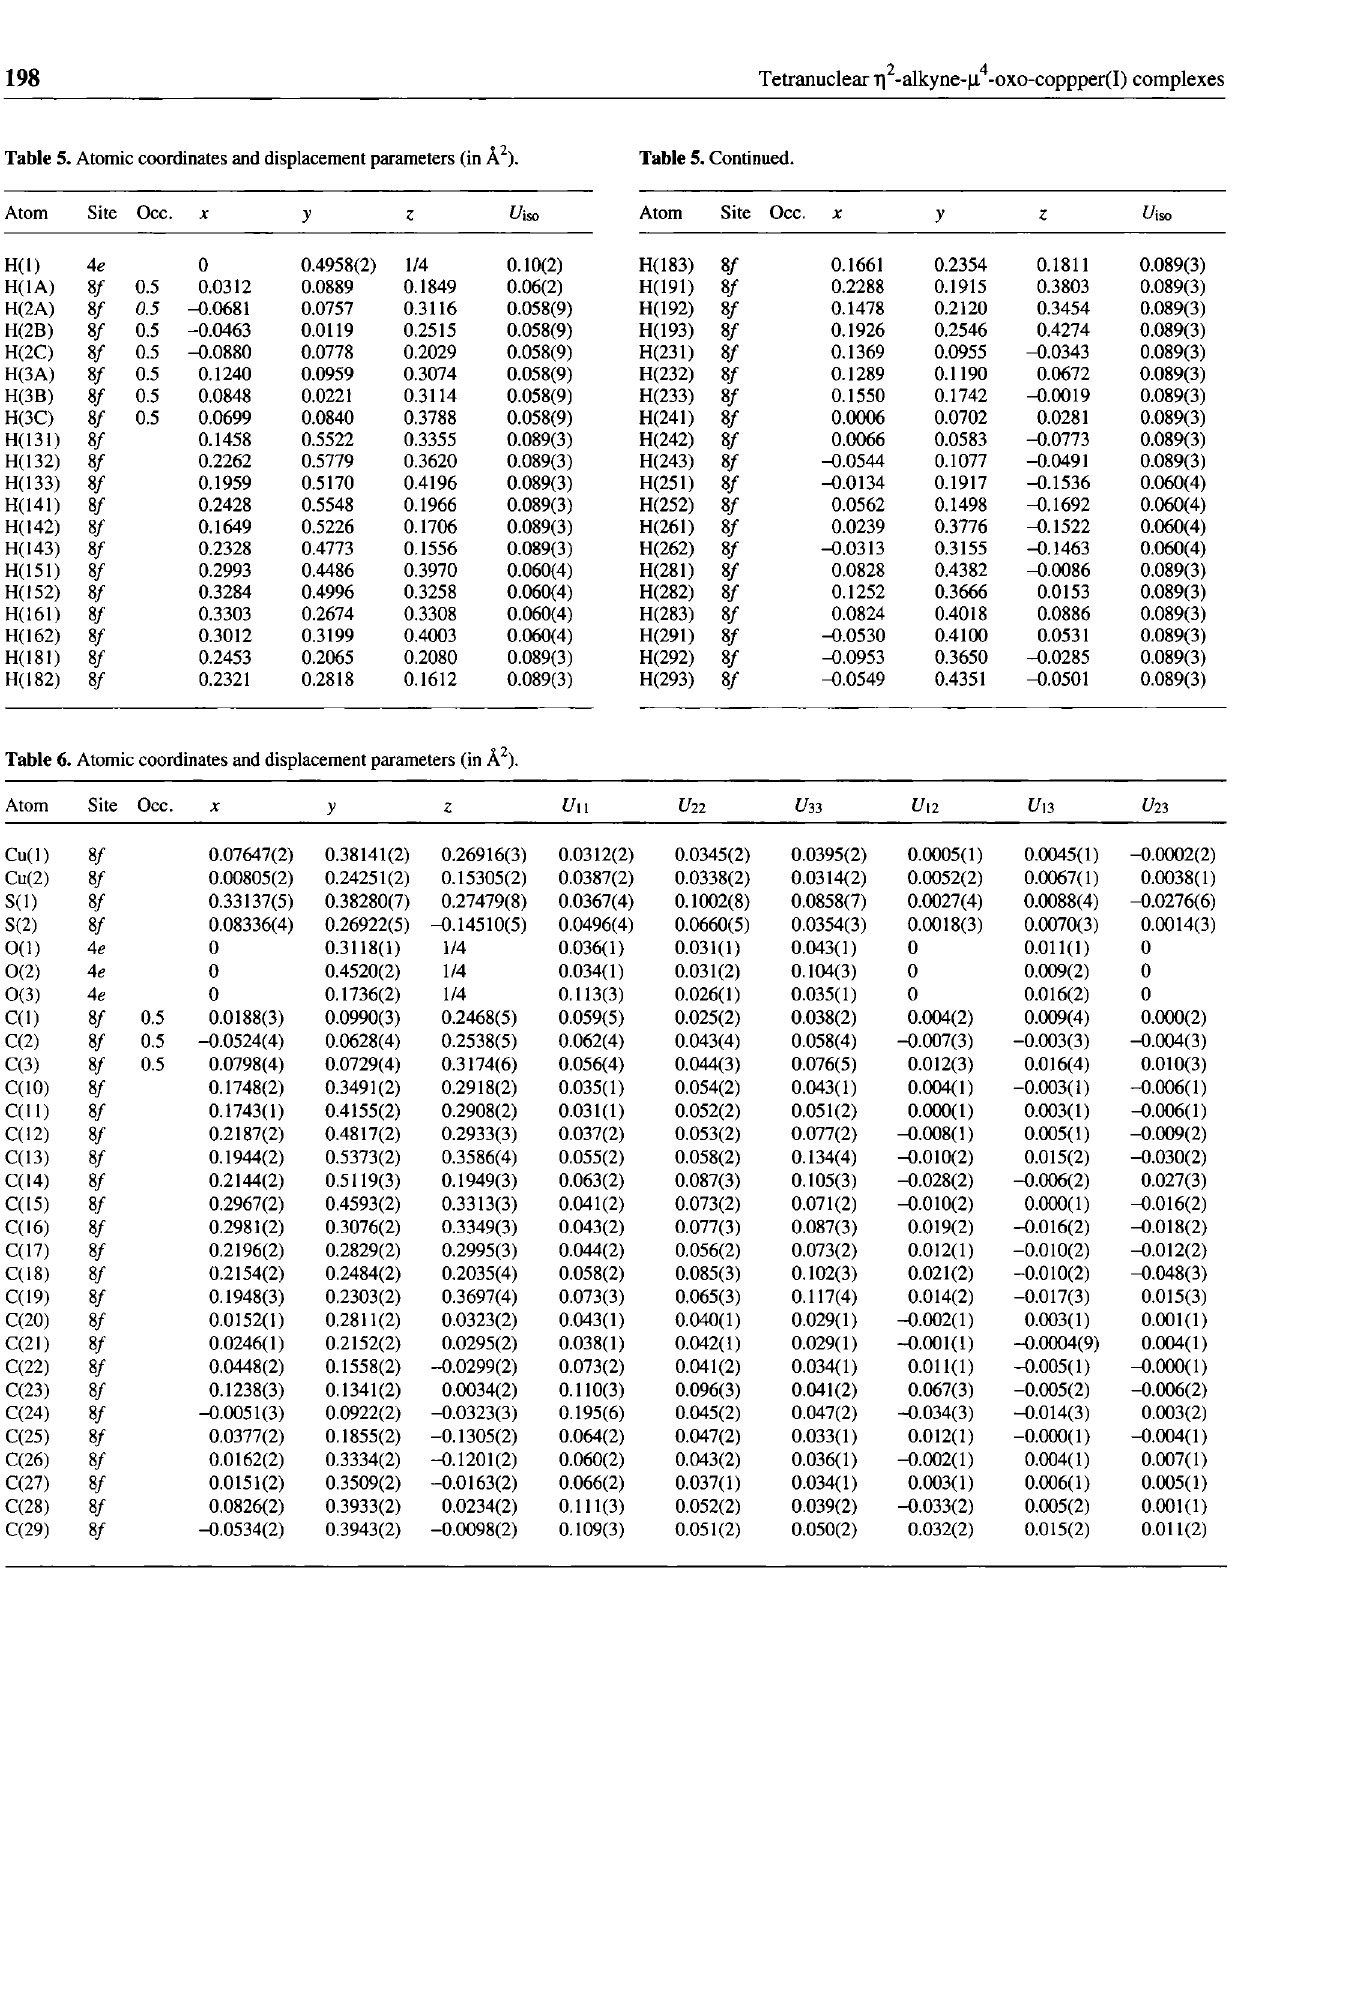
Table 5. Atomic coordinates and displacement parameters (in Ä 2 ). Table 5. Continued.